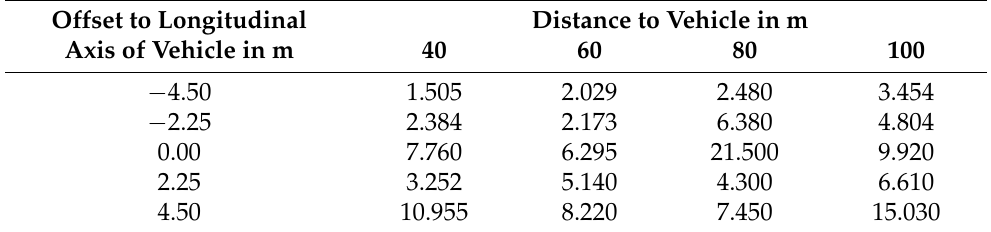
Table 3. Required Visibility Level on the different object positions in the light tunnel. Offset to